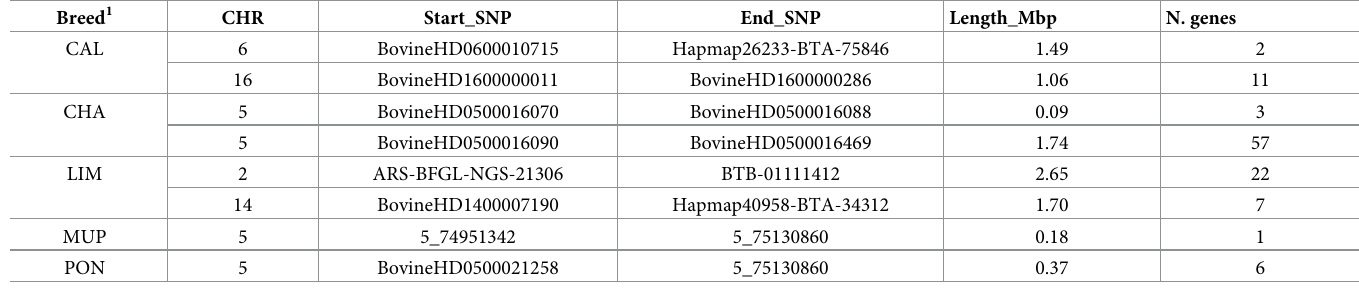
Table 4. Characterization of within-breed common runs of homozygosity at a threshold of 80% and with at least 15 SNPs and the number of genes included. Breed 1